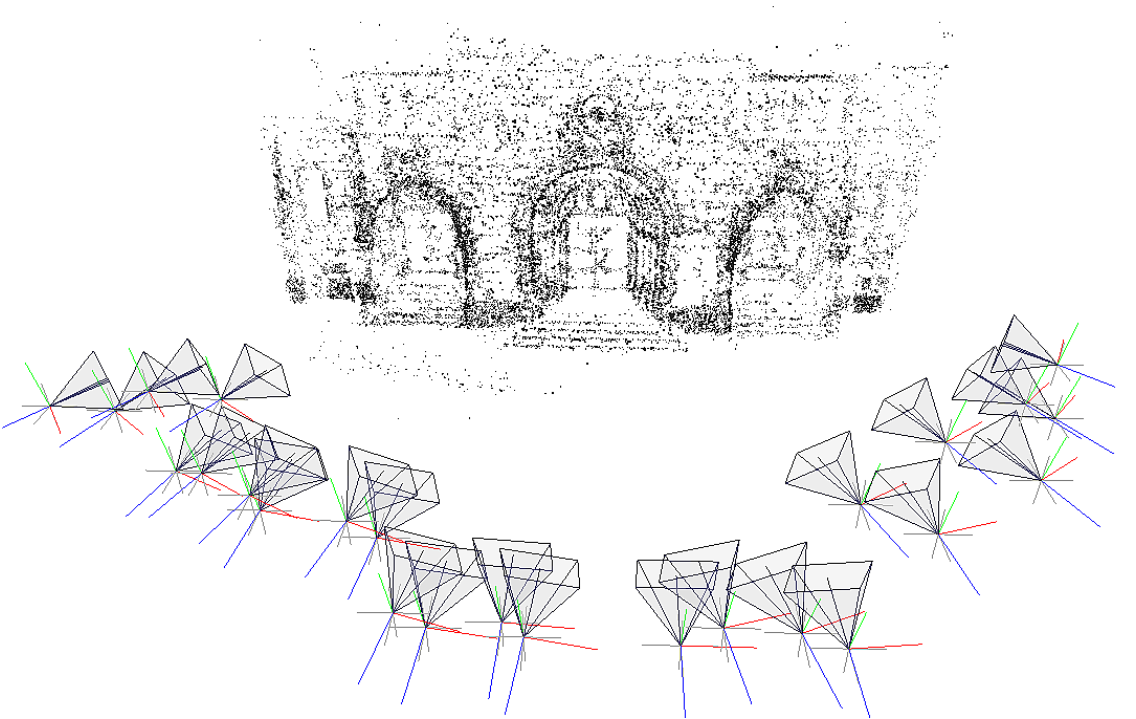
Figure 17. Sparse point clouds of Herz-Jesu-P25 sequence, generated by Visual SfM with the HashMatch. These point clouds have accurate camera poses which are very important for dense reconstruction procedures.